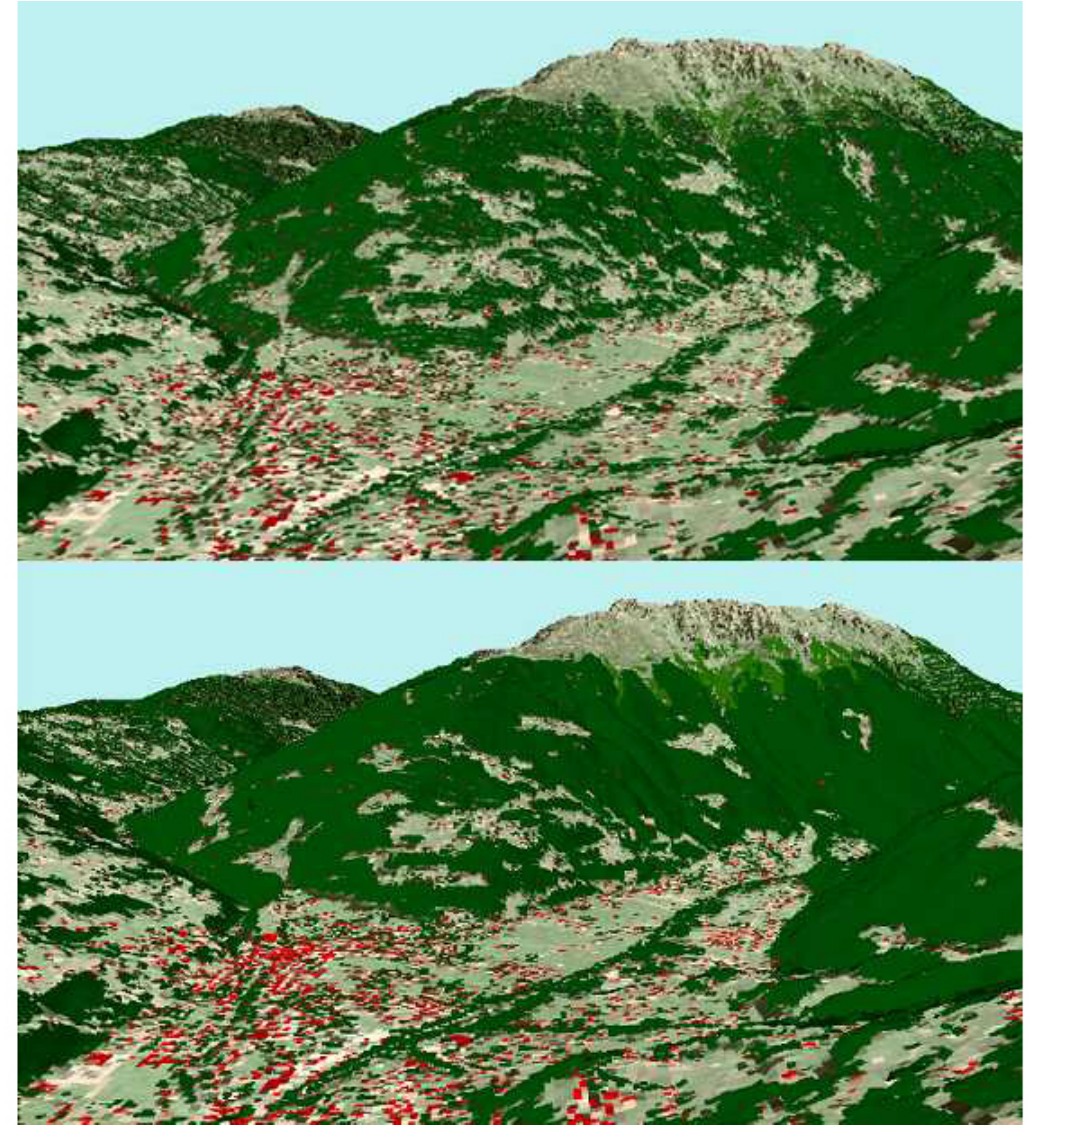
Fig. 3 . Future landscape transition (Top: situation 2005; bottom: dreadful landscape transition 2030 with accelerated settlement expansion and forest area growth, tree-line